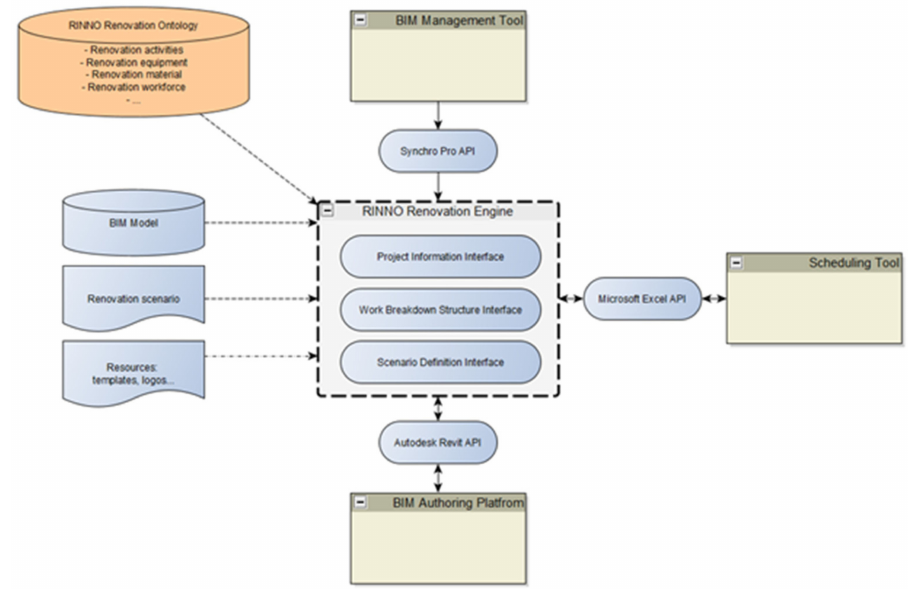
Figure 14. System architecture of the 4D BIM digital tool.